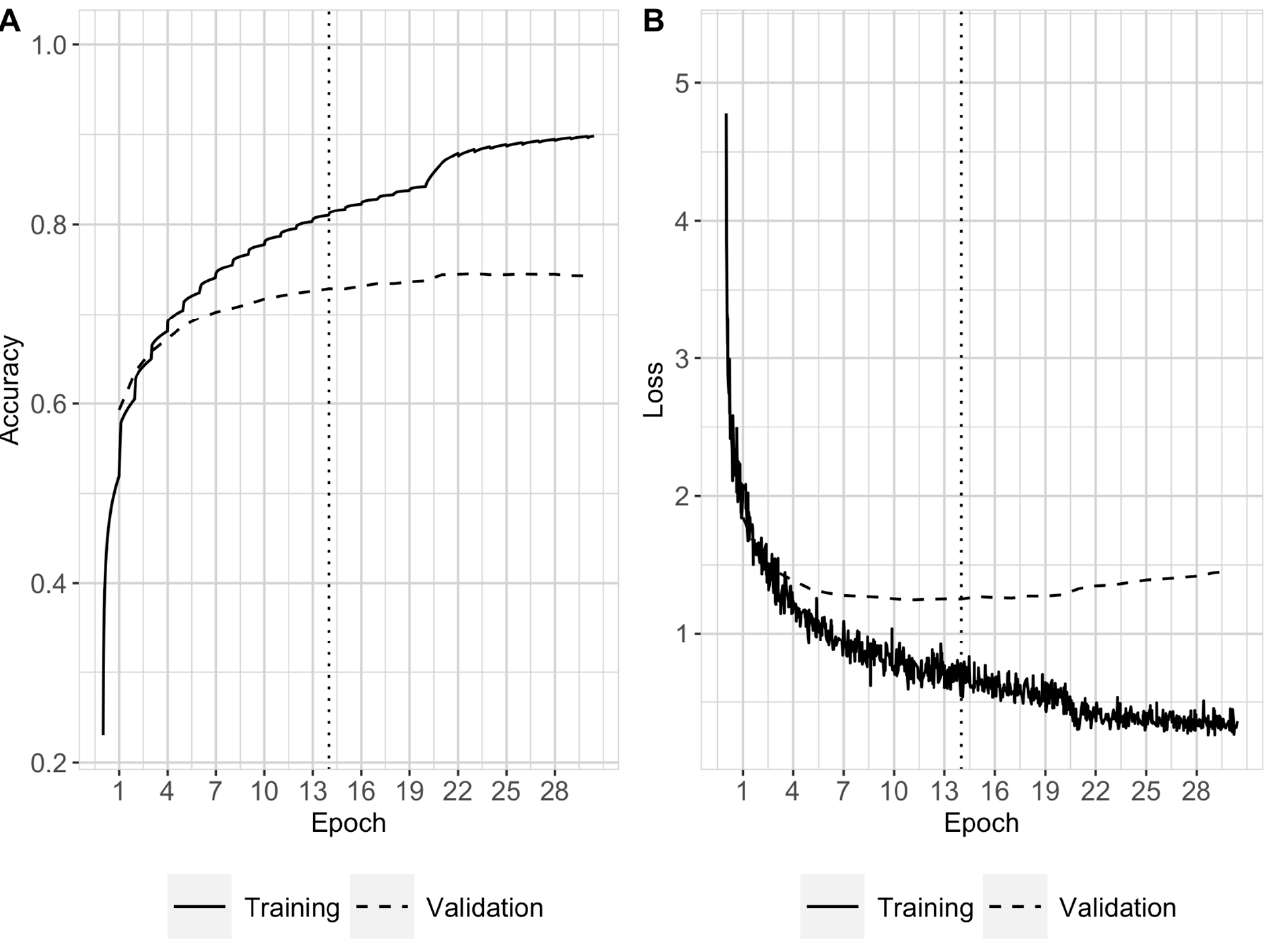
Figure 3. Learning curves representing the predictive performance of DL-TODA during training in terms of accuracy ( A ) and loss ( B ). The training loss and accuracy (solid line), validation loss and accuracy (dashed line), and epoch 14 at which the model was tested (dotted line) are reported.